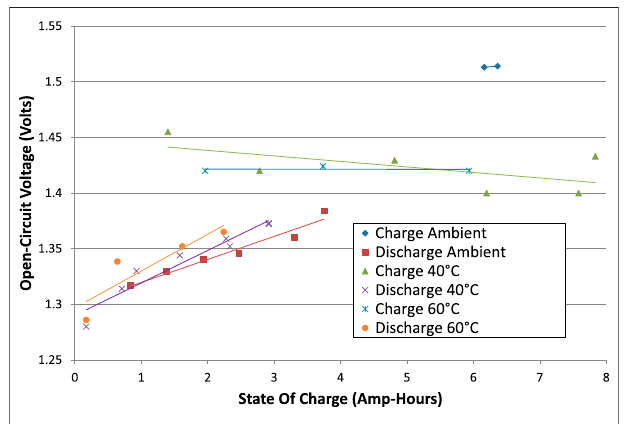
FIGURE5| Opencircuitvoltages(VOC)foralltests,comparingcharging with discharging, and comparing the effect of cell